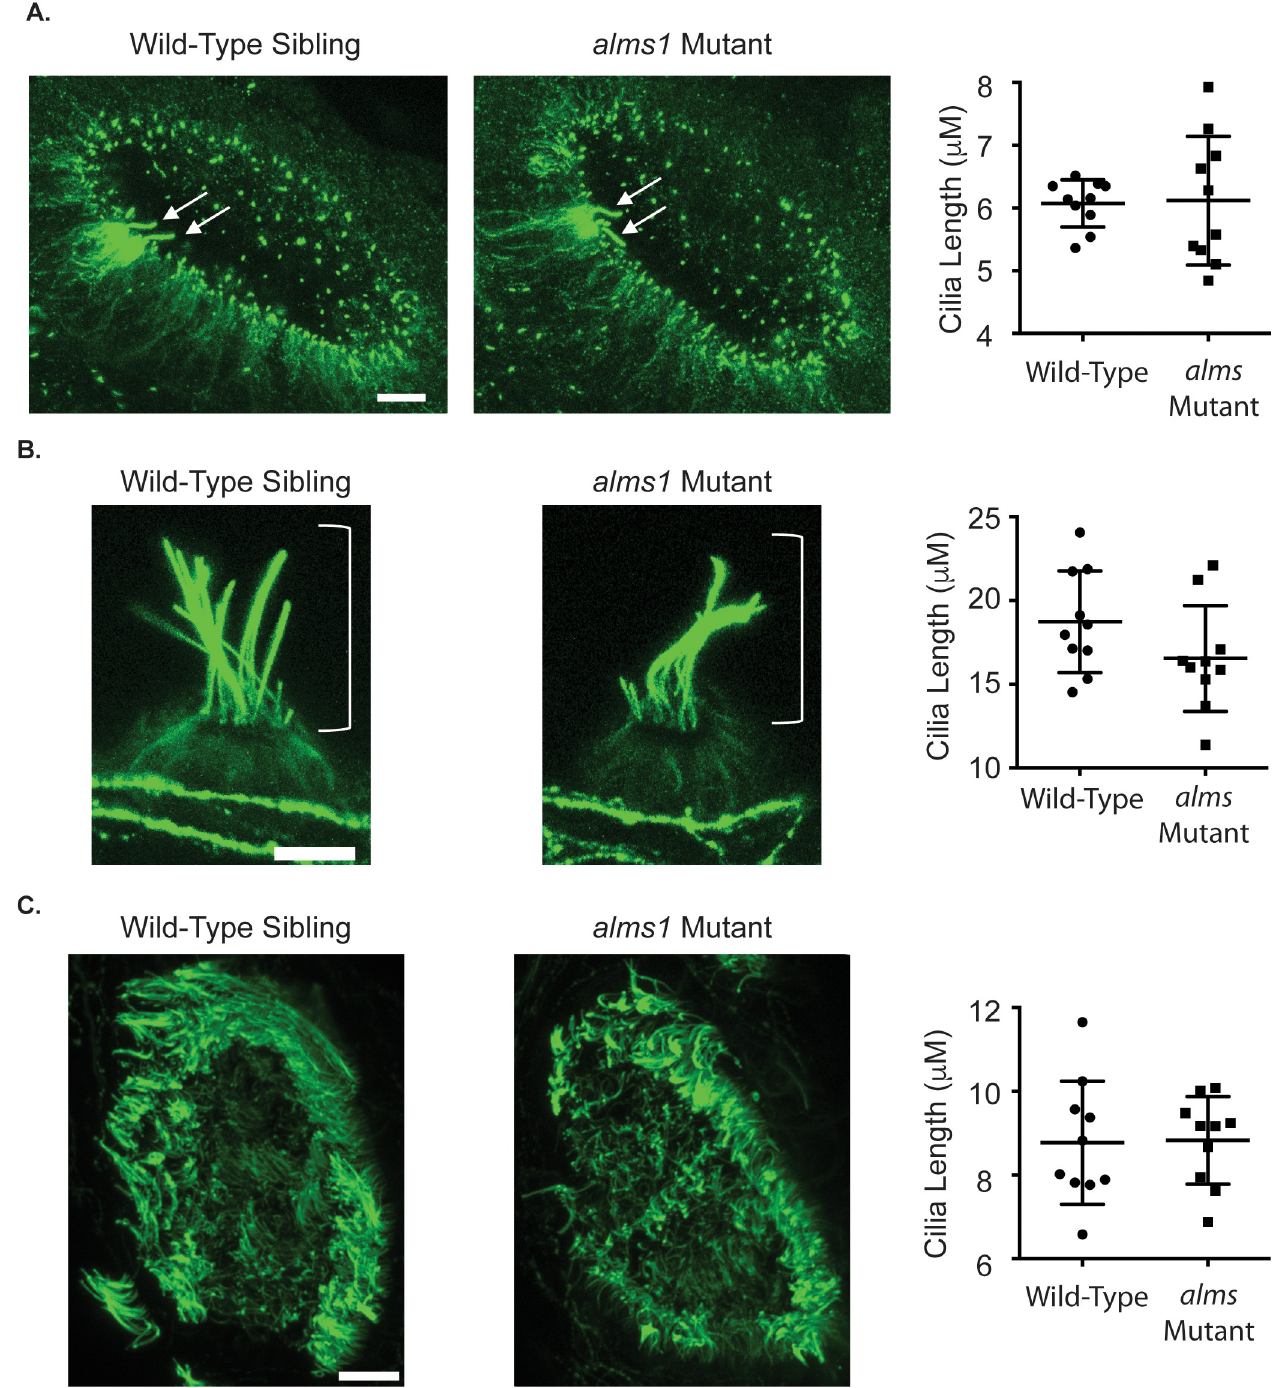
Fig 1. Cilia formation is largely normal in alms1 mutants. (A) Representative images of the otic vesicle of a 24 hpf wild-type (left) and alms1 mutant (center) zebrafish embryo stained with acetylated tubulin. The arrows point to the cilia of the early hair cells. To the right is quantification of cilia length. There was no significant difference in average kinocilia length between wild-type and mutant zebrafish, however, there was more variation in length seen in alms1 mutants. (p = 0.0065 by F test to compare variances) (B) Representative images of the IO1 neuromast stained with acetylated tubulin in wild-type (left) and alms1 mutant (center) 5dpf zebrafish larvae. The brackets show the position of the kinocilia. Kinocilia appear grossly normal in alms1 mutant fish. To the right is quantification of IO1 kinocilia length. There was no significant difference between wild-type and mutant zebrafish (p = 0.1312 by an unpaired t-test) (C) Representative images of the olfactory pit stained with acetylated tubulin in wild-type (left) and alms1 mutant (center) 5dpf zebrafish larvae. Again cilia appear